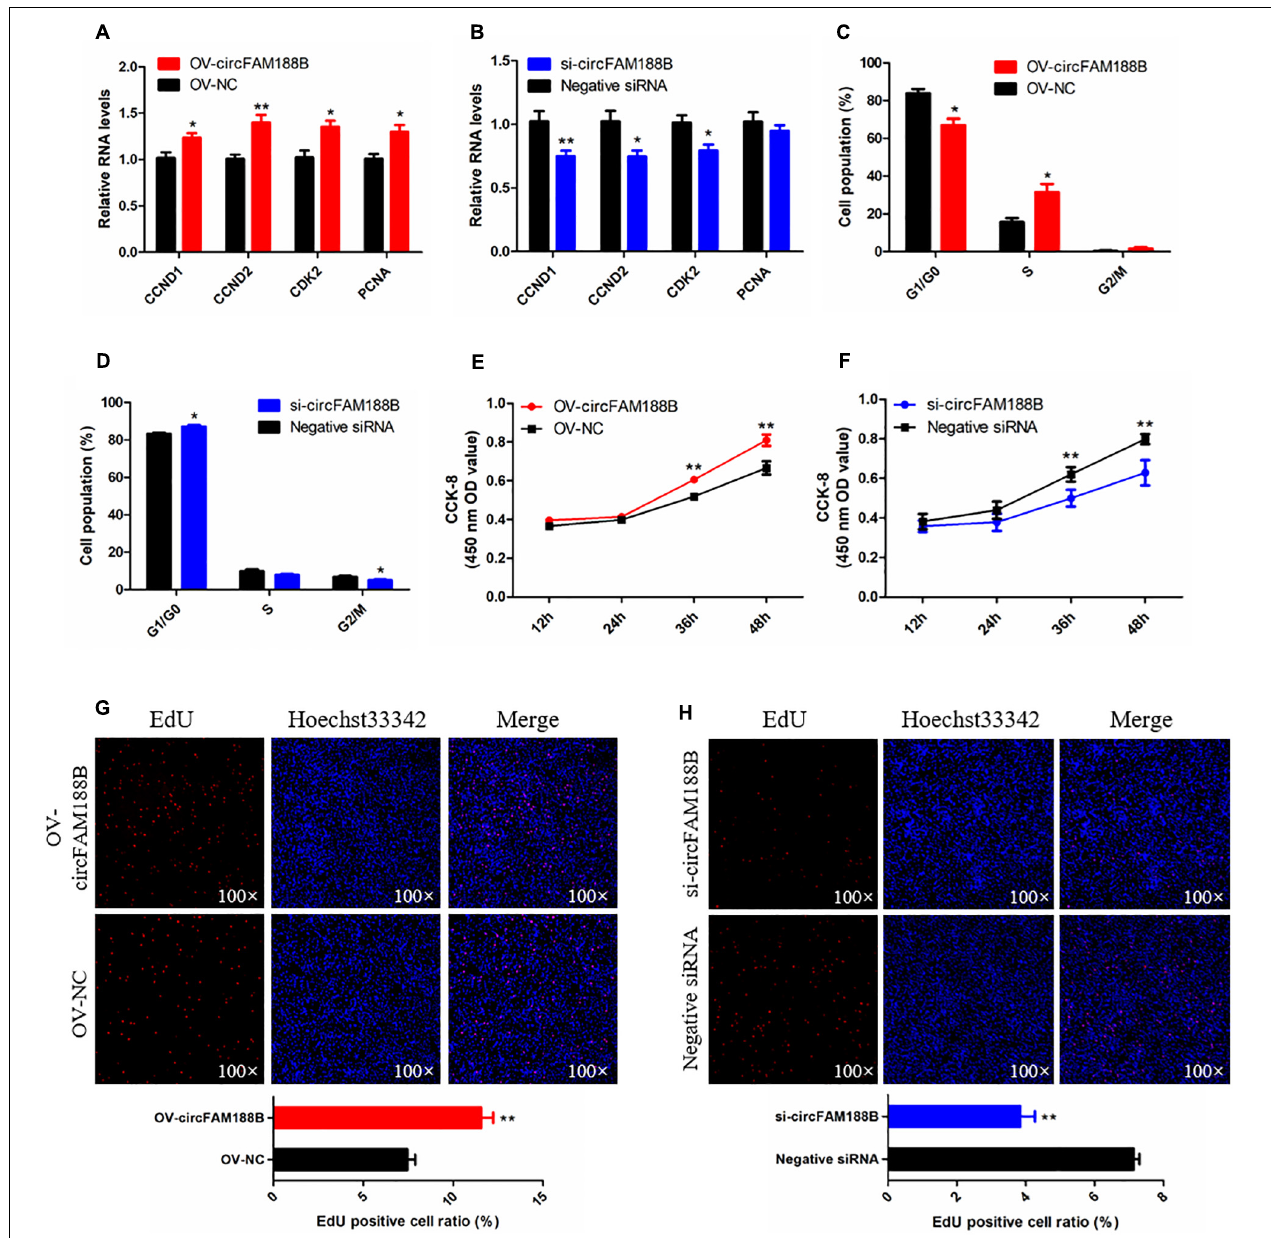
FIGURE 2 | CircFAM188B promotes proliferation of chicken SMSCs. (A,B) The relative RNA level of cell proliferation-related genes in chicken SMSCs following circFAM188B overexpression or inhibition. (C,D) Cell cycle analysis of SMSCs following circFAM188B overexpression or inhibition. (E,F) The growth curve of SMSCs following circFAM188B overexpression and inhibition. (G,H ) Fluorescence microscope images of proliferating chicken SMSCs labeled with EdU following circFAM188B overexpression or inhibition (upper panels) . Proliferation rates of chicken SMSCs following circFAM188B overexpression or inhibition (lower panels) . The results of all groups are shown as mean ± S.E.M., and the data represent three independent assessment methods. Student’s t -test was used to compare expression levels or values among different groups. * P < 0.05; ** P <